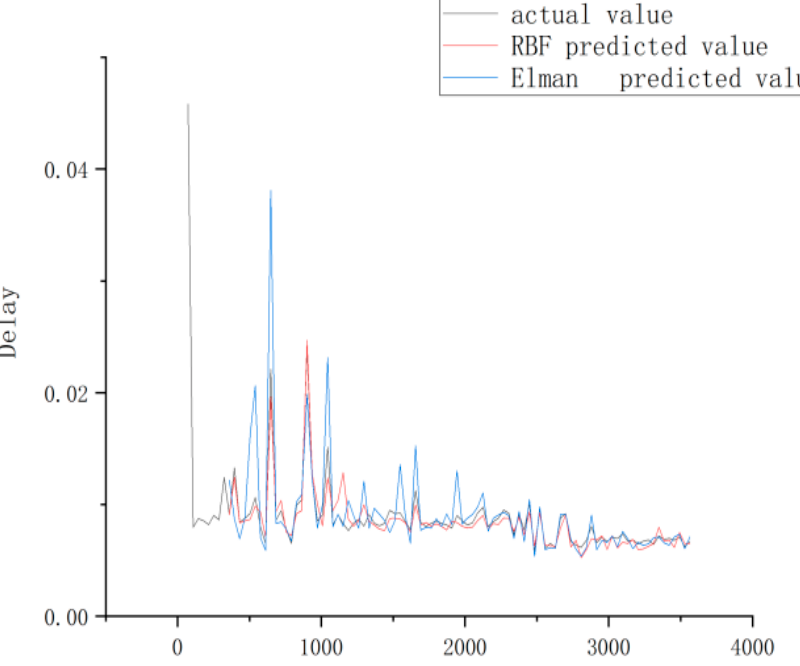
Figure 24. Comparison of latency prediction results based upon the RBF and Elman networks. Table 1. RSM value comparison.